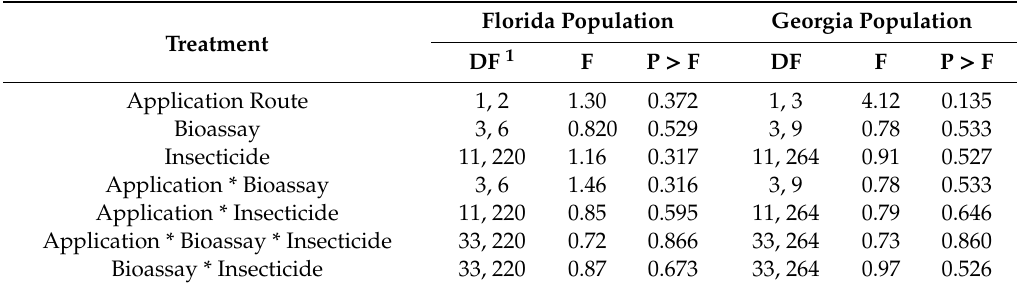
Table 3. E ff ects of treatments and their interactions on nymph numbers for a Florida and Georgia whitefly population, Coastal Plain Exp. Station, Tifton, GA, USA, 2019.